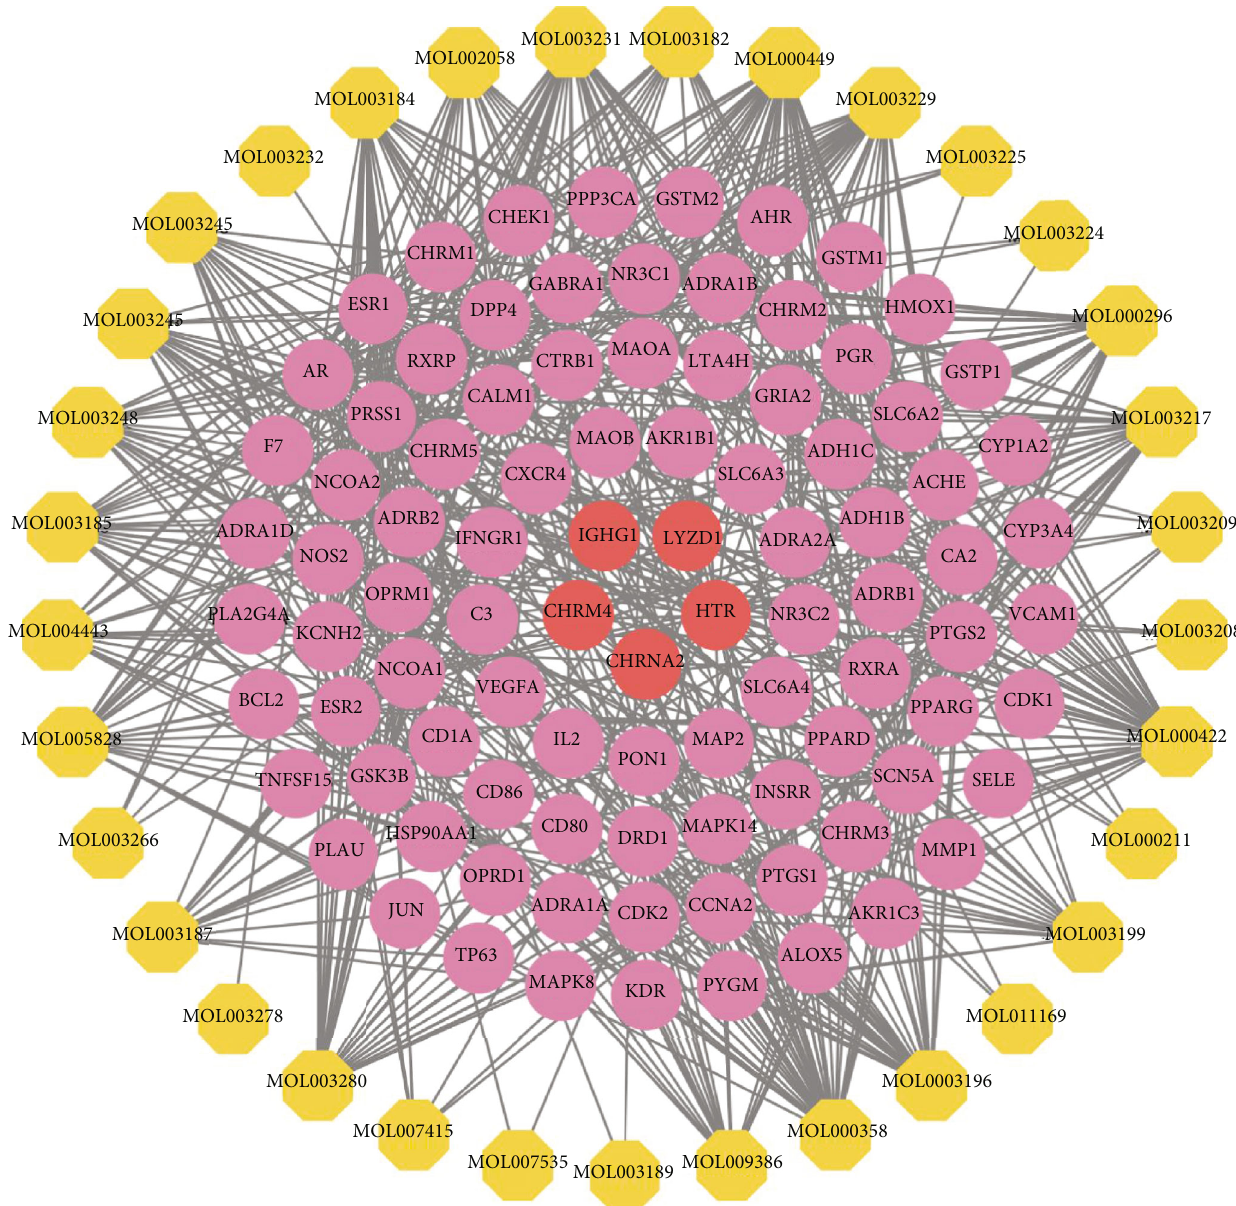
Figure 3: Compound-compound target network of targets in TwHF. The yellow hexagon stands for compounds in TwHF. The nodes represented target genes of TwHF, in which pink nodes stand for common target of TwHF-DKD, and red nodes were employed to represent compound targets not related to DKD. The lines stand for interactions between compounds and target